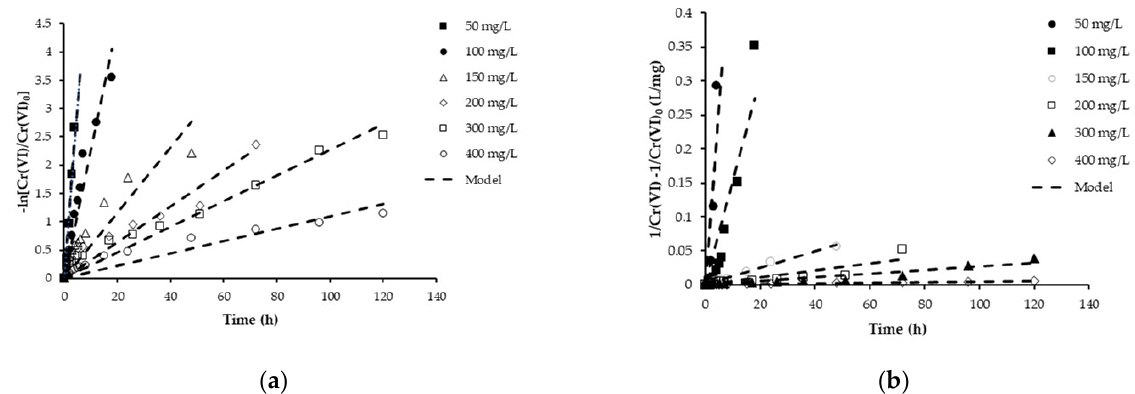
Figure 6. The kinetics of Cr(VI) reduction by bacterial consortia at different Cr(VI) initial concentration ( a ) pseudo-first-order kinetics ( b ) second-order kinetics. Table 2. First and second order kinetic of Cr(VI) reduction by bacterial consortia and their correla- tion coefficient.